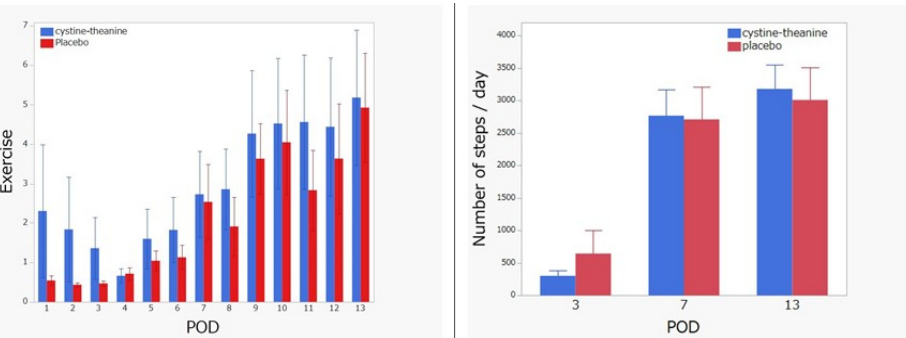
Figure 2. Exercise and number of steps. There was no difference between the two groups, although the CT group showed better exercise and the number of steps in every investigated period (except day 3). Exercise is the value obtained by multiplying metabolic equivalent (MET) and the activity time (h) when the physical activity intensity is ≥ 3